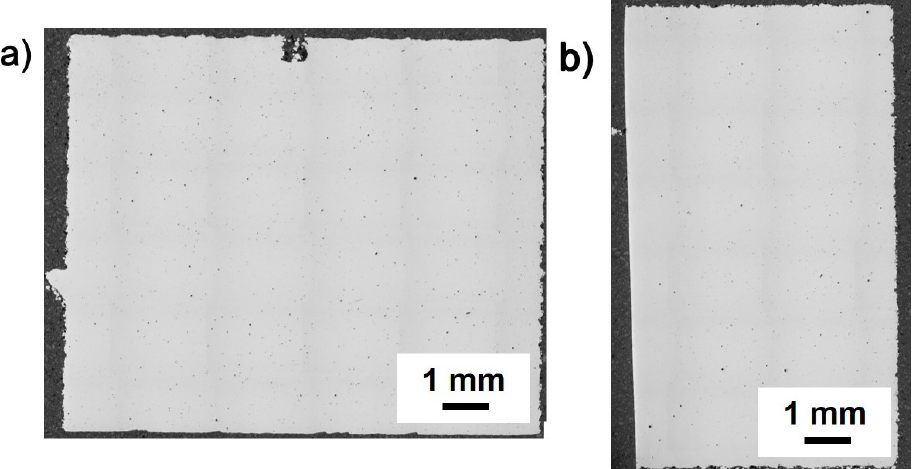
Figure 5. Image showing ( a ) XZ and ( b ) XY cross sections for full density samples. The average relative density for these samples was recorded to be 99.8%.